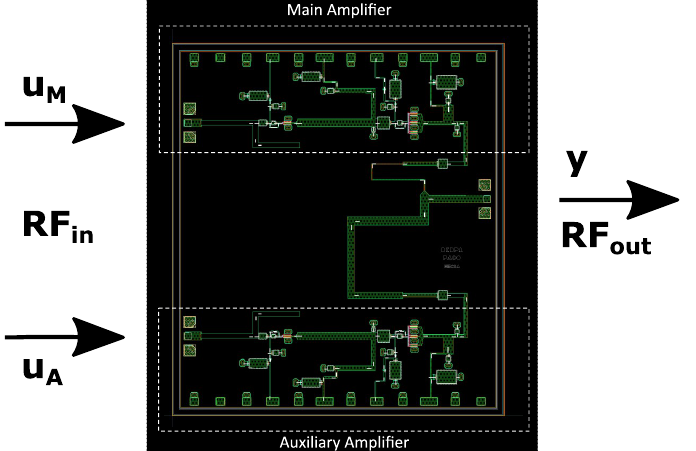
Figure 2. Layout of the simulated DIDPA MMIC with labeling of the main and auxiliary branch RF inputs (respectively, u M and u A ), and the RF output ( y ).